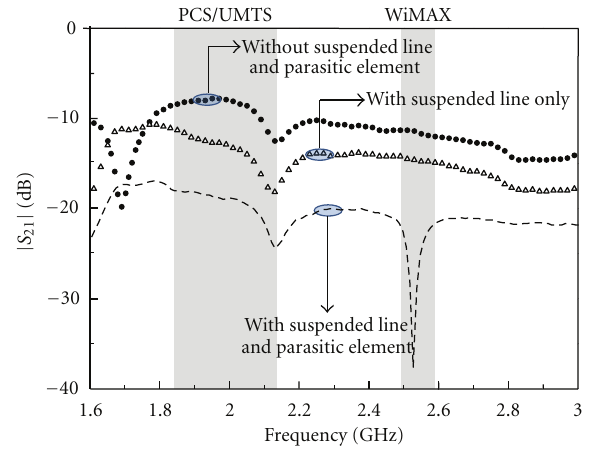
Figure 4: Measured isolations ( S 21 ).